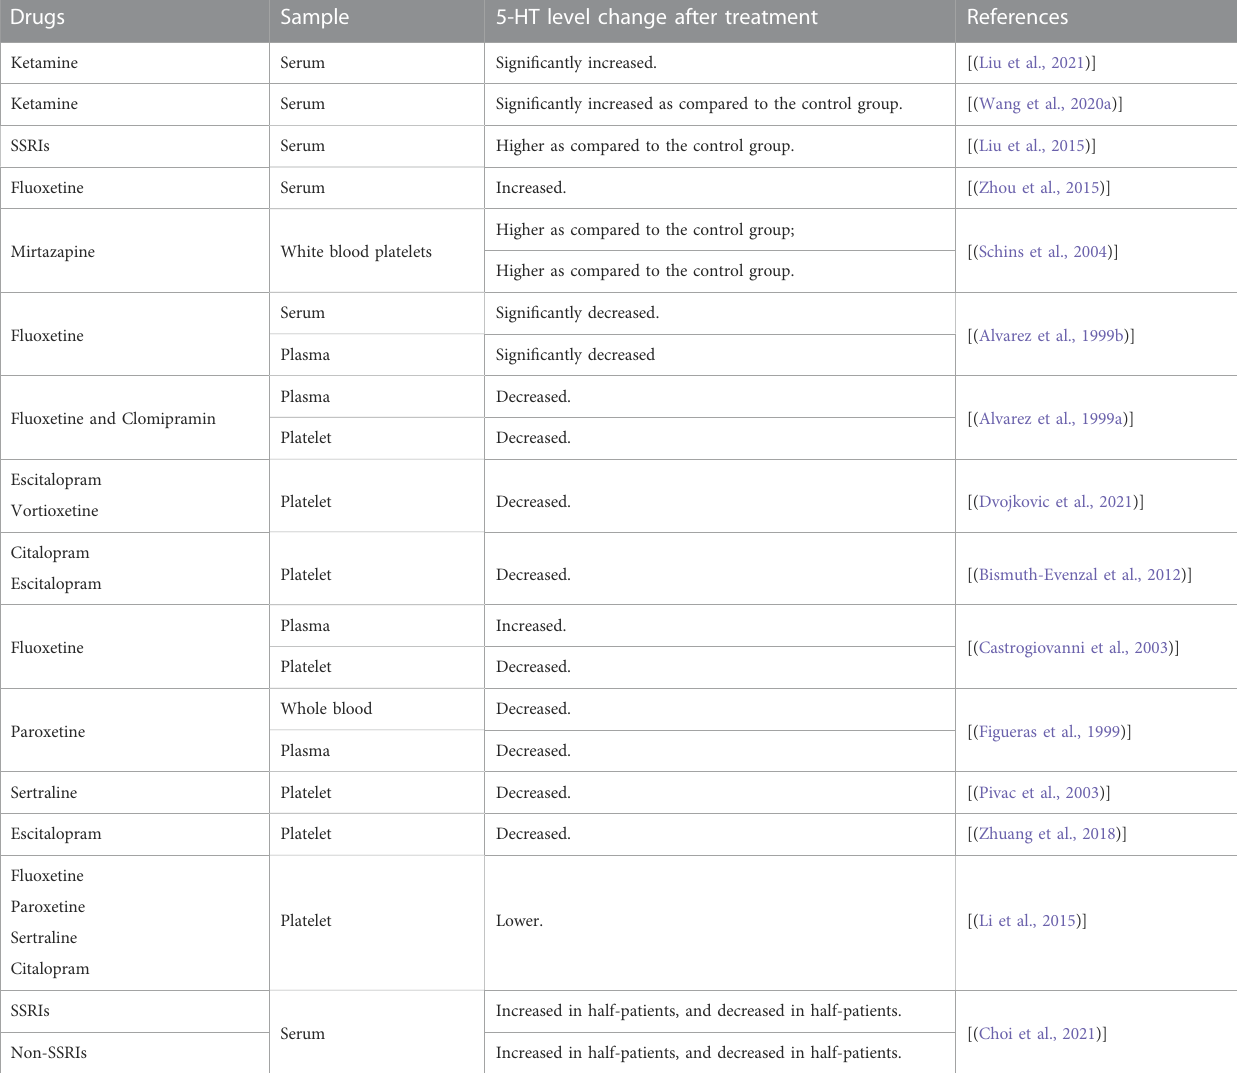
TABLE 2 Changes of peripheral 5-HT level in patients with depression after drug treatment. Drugs